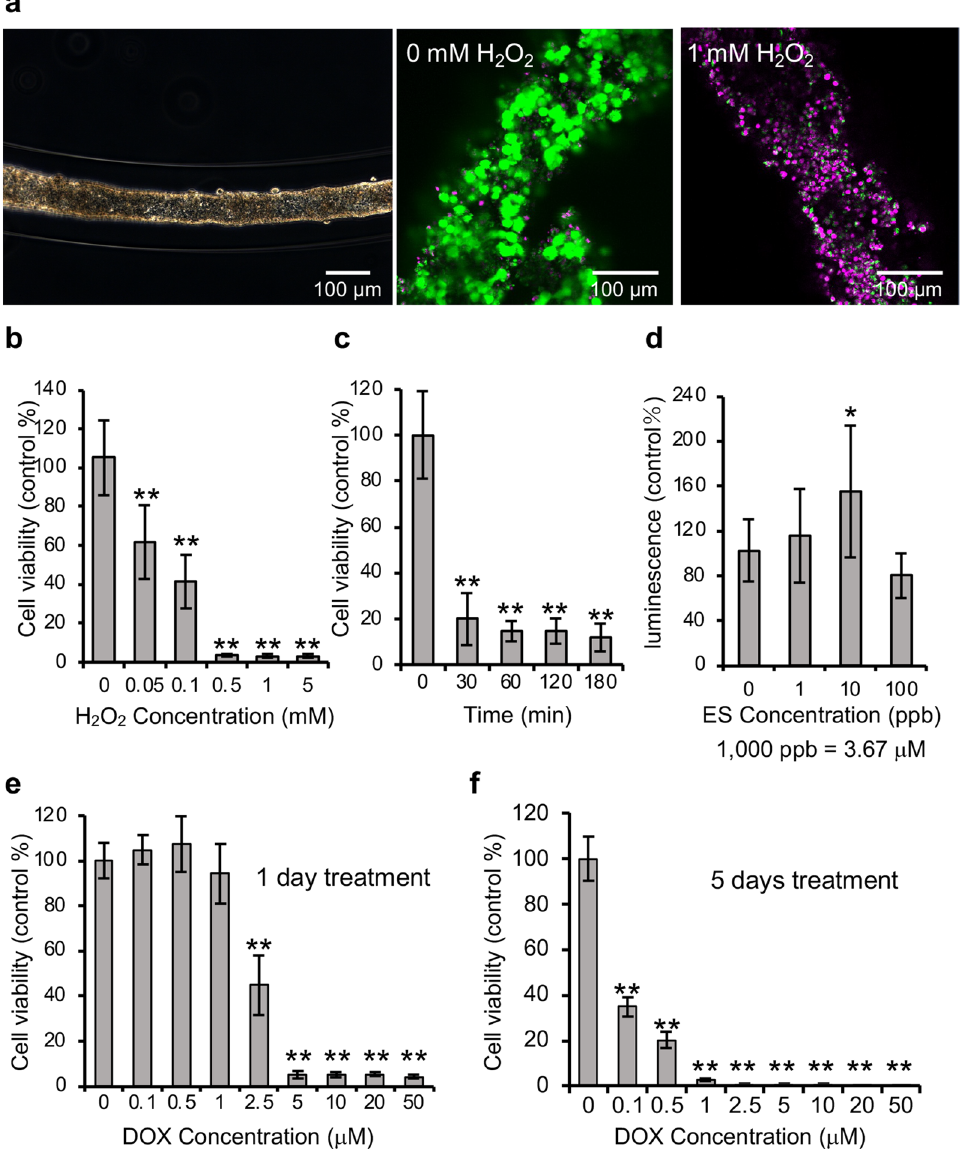
Figure 5. Cell viability of HeLa CF fragments following H 2 O 2 , β-estradiol, and DOX treatment. ( a ) Phase- contrast image of HeLa CF fragment at 10 days in culture (left). Fluorescence images of live/dead assay of HeLa CF fragments treated with 0 or 1 mM H 2 O 2 for 24 h after 10 days in culture (middle and right). The live and dead cells exhibited green and magenta fluorescence, respectively. ( b ) Graphs of cell viability after treatment of HeLa CF fragments at 10 days in culture with various H 2 O 2 concentrations (0–5 mM) for 24 h, ( c ) with 0.5 mM H 2 O 2 for 30, 60, 120, and 180 min. ( d ) Graph of luminescence after treatment of HeLa CF fragments at 10 days in culture with 0–100 ppb β-estradiol (ES) for 48 h. ( e ) Graphs of cell viability after treatment of HeLa CF fragments at 10 days in culture with various DOX concentrations (0–50 μM) for 1 day and ( f ) 5 days. The experiment was repeated three times with n = 4 (** P < 0.01, * P <